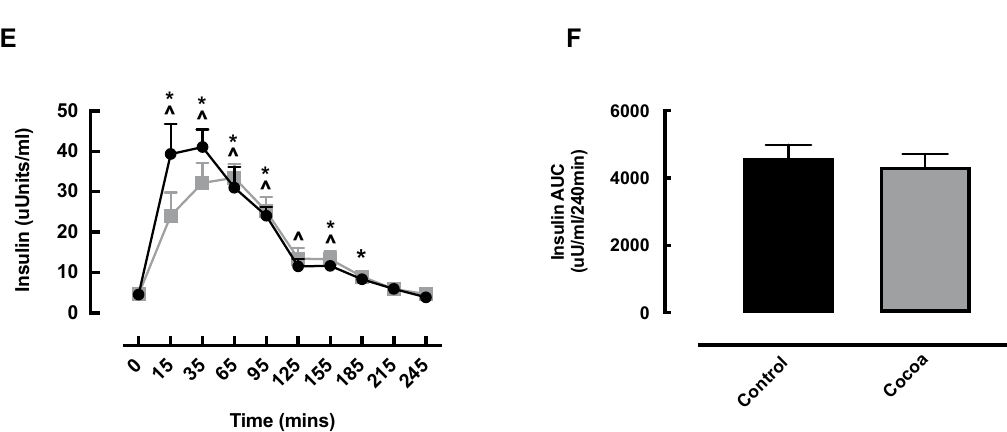
Figure 4. Changes in arterial glucose ( A ), venous glucose ( B ), glucose A-V balance ( C ), glucose uptake ( D ), insulin ( E ) and insulin AUC ( F ) in healthy older adults in response to cocoa or control, following oral nutritional supplement feeding. ~ denotes a significant difference between conditions ( p < 0.05); ^ denotes significant difference from control baseline ( p < 0.05); * denotes significant difference from cocoa baseline ( p < 0.05). AUC, area under the curve; A-V, arterio-venous.